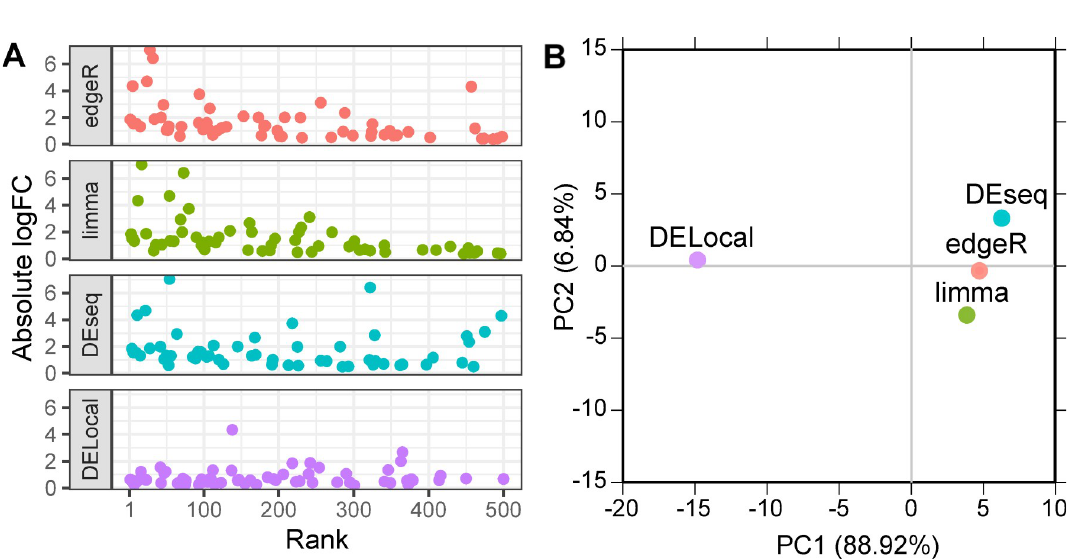
Fig 8. DELocal provides an alternative ranking of differentially expressed genes. (A) Unlike the other methods, DELocal rankings of differential expression do not bias towards genes with large log-fold changes (1 denotes the highest rank). (B) Principal component analyses of the rank orders of tooth developmental genes shows the ordering of the DELocal to be distinct from the ones provided by the other three methods (using correlation matrix of top 500 tooth genes).